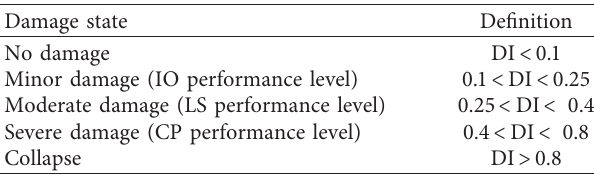
Table 8: The relation between damage index and damage state.